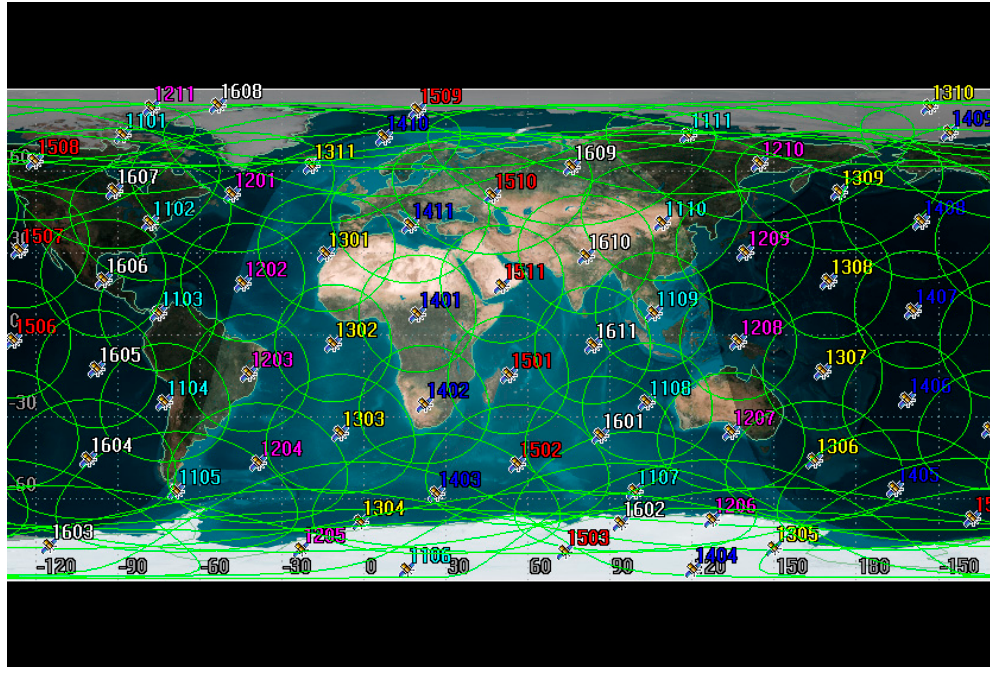
Figure 5. Geographic coverage of Iridium satellite.